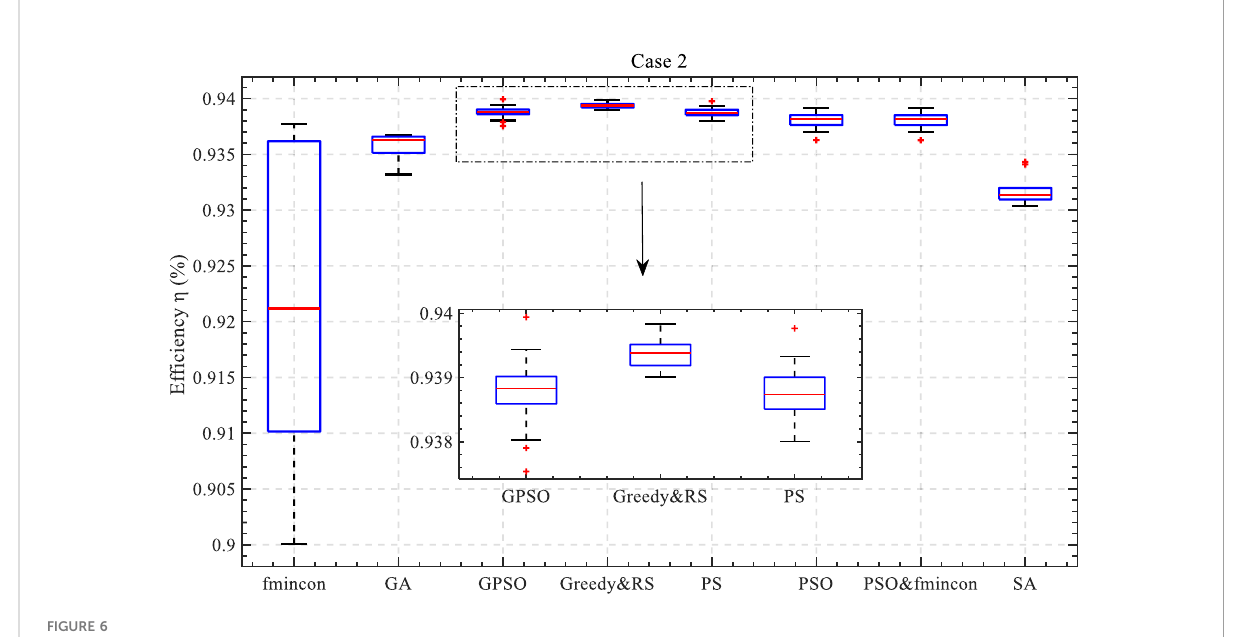
FIGURE 6 Boxplot of wind farm ef fi ciency using different optimization